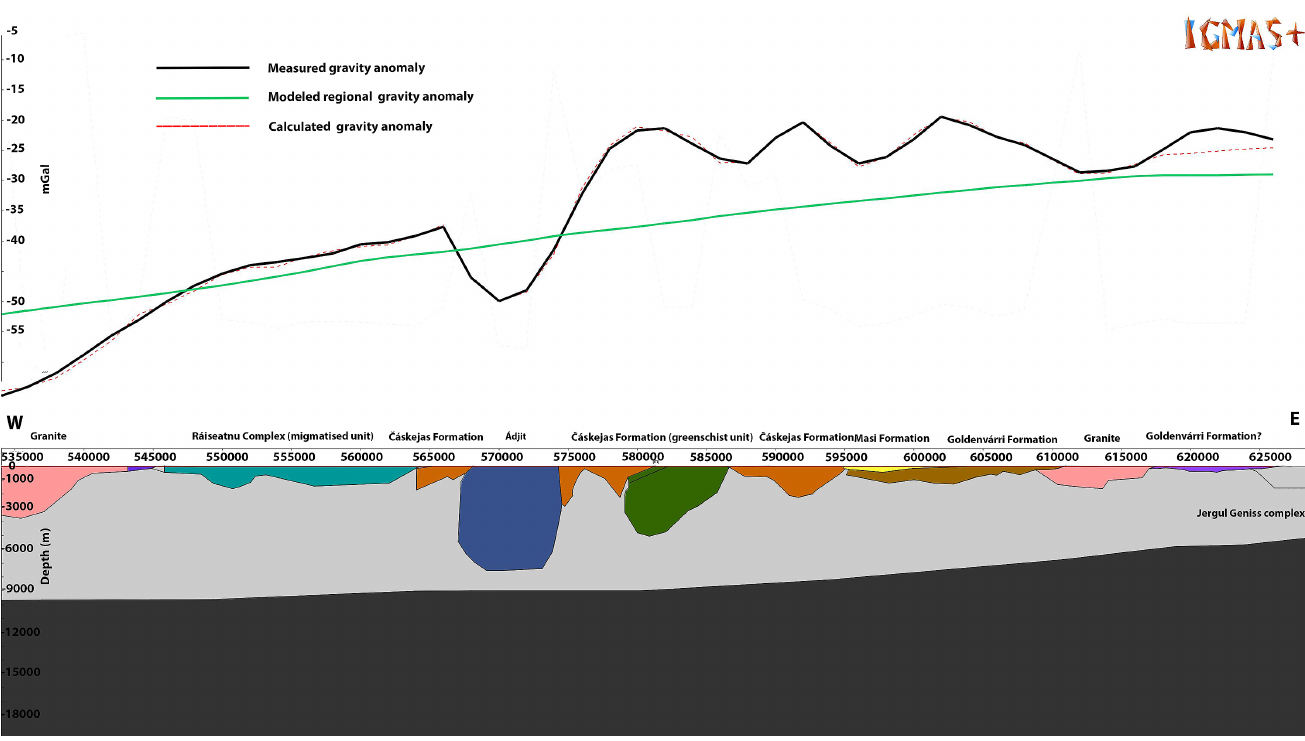
Figure 15. Selected vertical slice 2 (P2) through the 3D density/structural model in Fig. 12. The black line shows the measured data. The dashed red line depicts the modelled data, and the green line shows the regional trend.